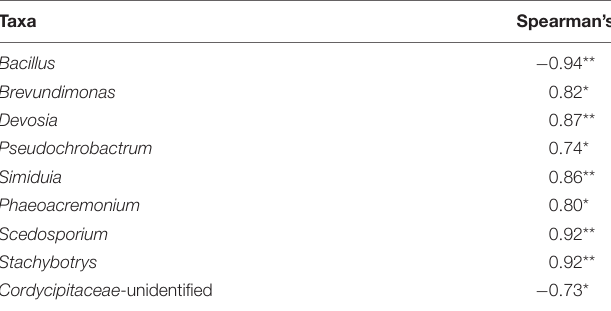
TABLE 1 | Spearman correlation of total organic carbon removal rate and dominant taxa in remediating waste drill cuttings (WDCs). Taxa